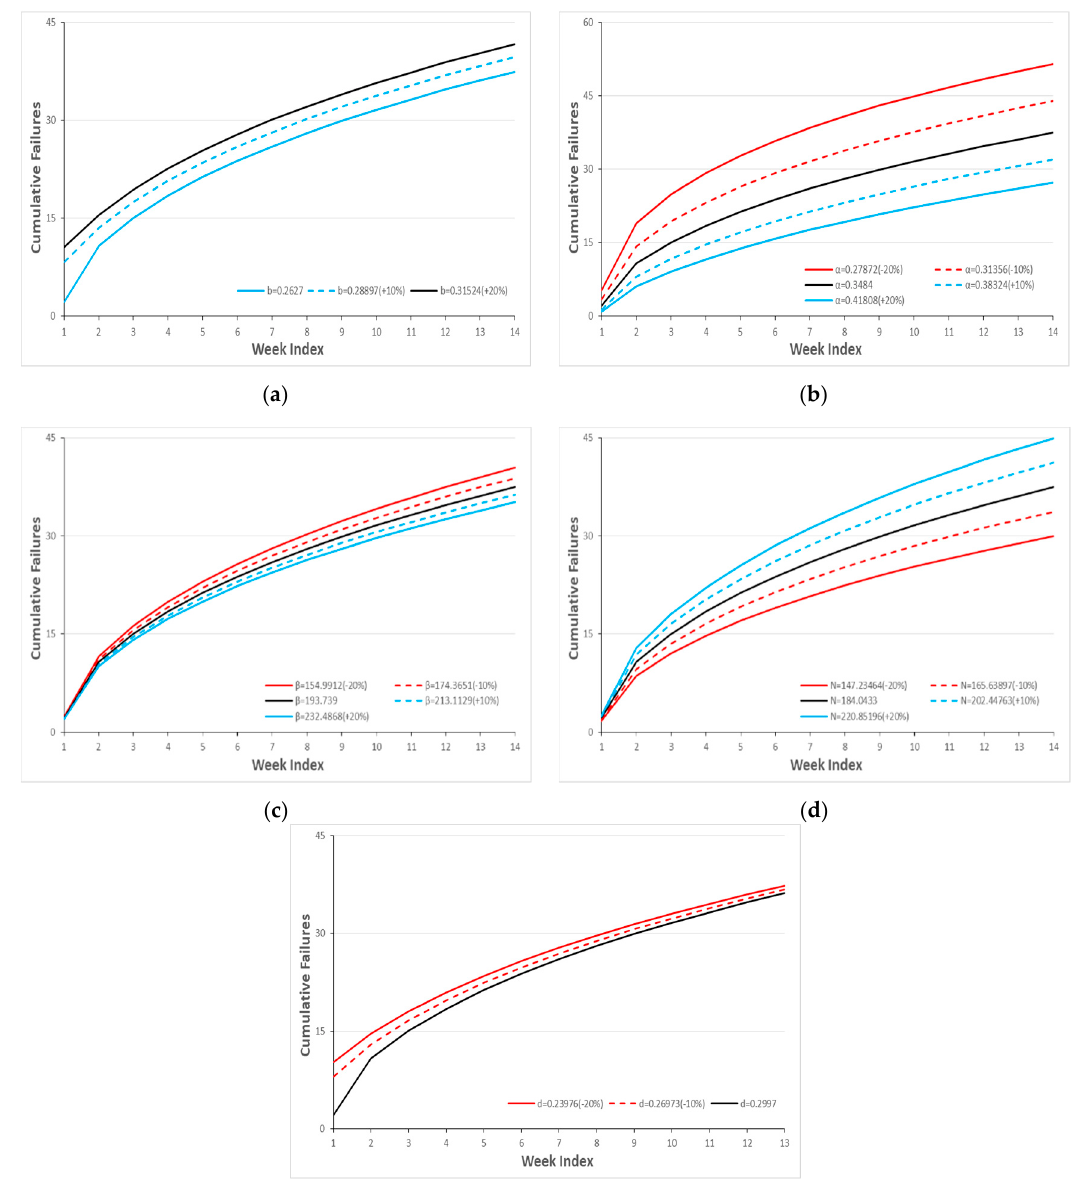
Figure 9. Sensitivity analysis of the parameters of the proposed model for dataset #1 ( a ) parameter b; ( b ) parameter α ; ( c ) parameter β ; ( d ) parameter N; ( e ) parameter d.